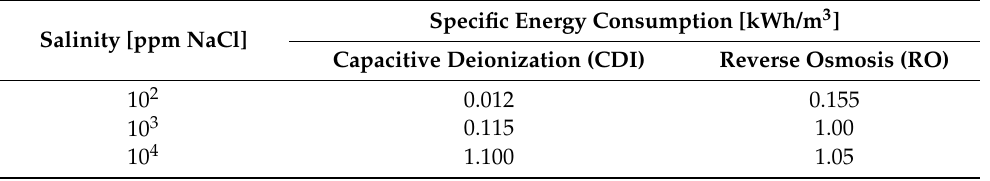
Table 12. Specific energy consumption required for RO and CDI desalination technologies as a function of water salinity, after [21].